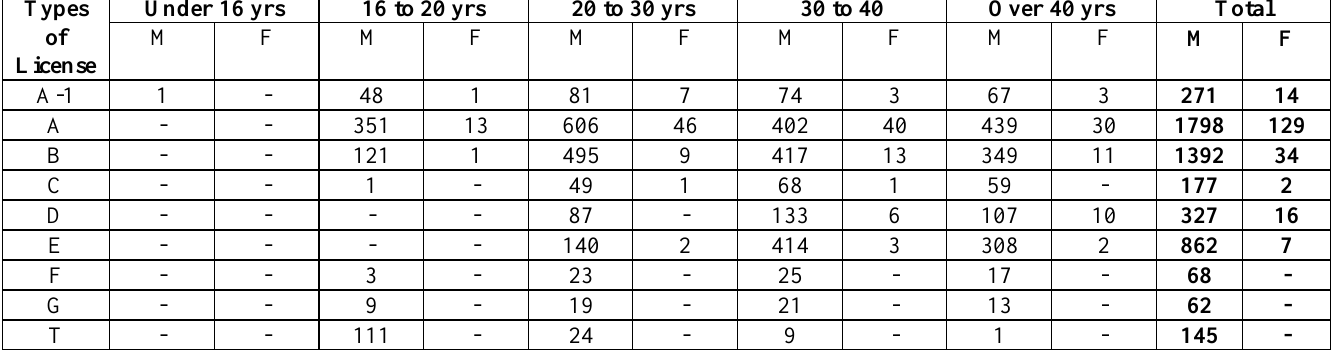
Table 18: Accidents by Types of Driving License, Age and Gender (1/2019~6/2019).